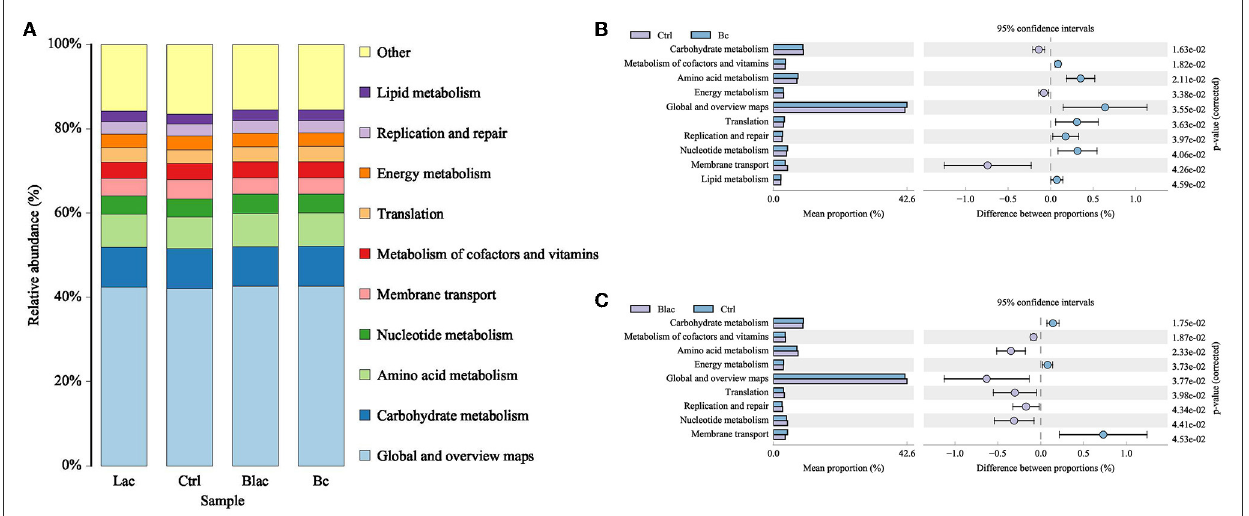
FIGURE9 Histogram of function prediction results (A) and analysis of differences in metabolic pathways between Bc group and Ctrl group (B) , Blac group and Ctrl group (C) ; Bc, added with strain B. cereus AH7-7; Blac, added with strain B. cereus AH7-7, Lactobacillus plantarum, and Lactobacillus buchneri ; Lac, added with Lactobacillus plantarum and Lactobacillus buchneri ; Ctrl, no